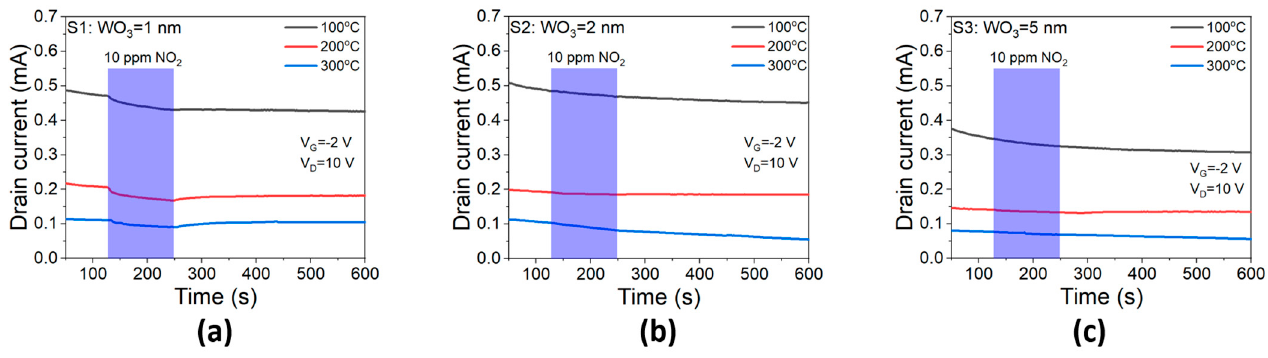
Figure 5. Response to 10 ppm NO 2 of the sensors at different temperatures. ( a ) 1 nm ( b ) 2 nm ( c ) 5 nm of WO 3 layer.